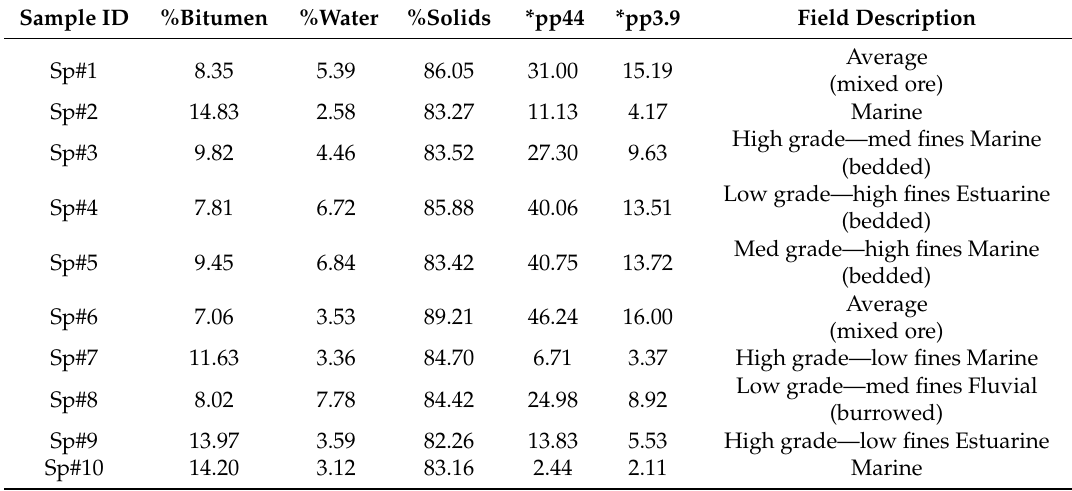
Table 1. Characteristics of the ten oil sands samples used for the flotation